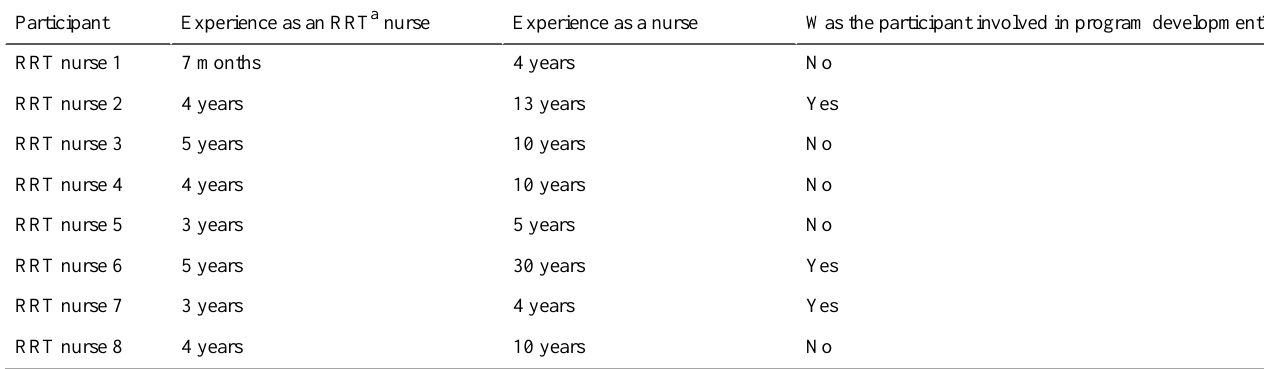
Table 1. Characteristics of rapid response team nurse participants.